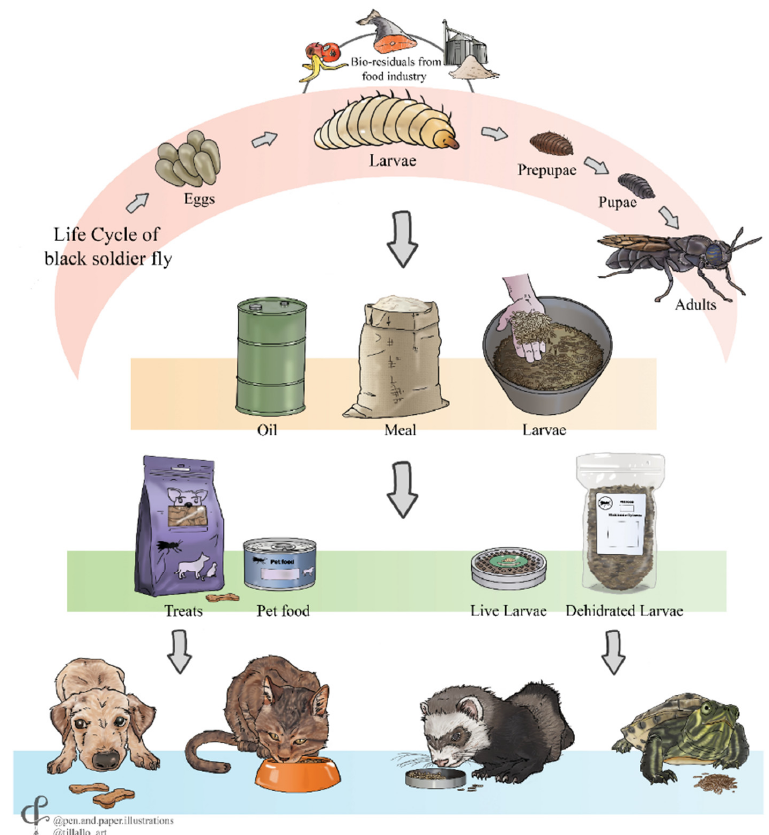
Figure 2. Flow diagram showing the different stages of the black soldier fly larvae processing cycle to generate various food ingredients used in pet